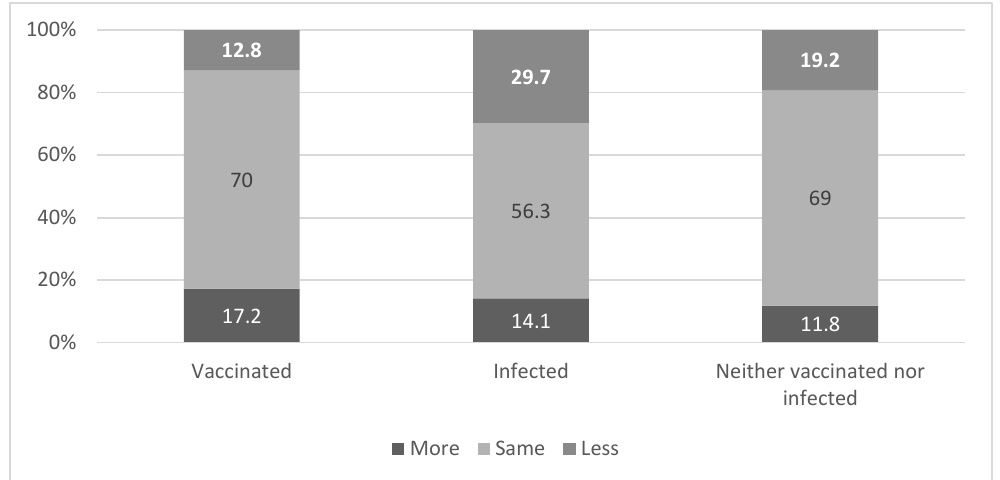
Figure 1. Level of change in social distancing after the beginning of the vaccination campaign by vaccinated and infected variable. χ 2 = 19.32 p = 0.001.